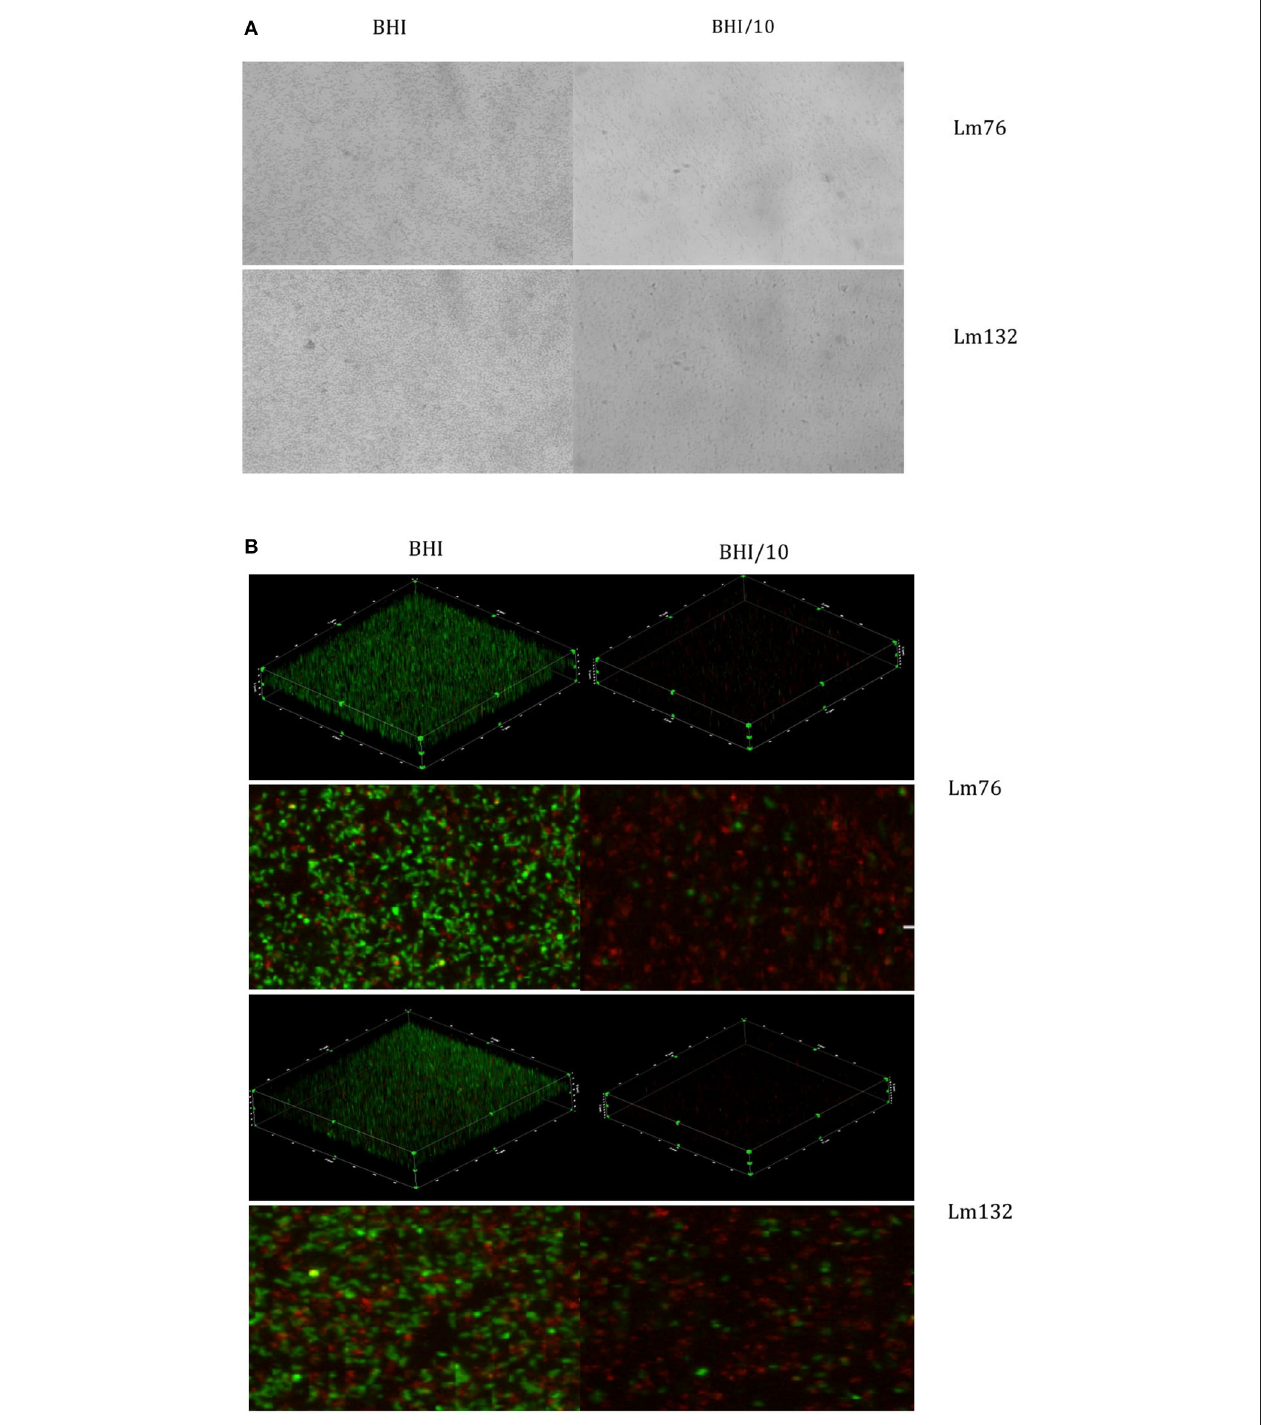
FIGURE 3 | Biofilm visualization of two strains of Listeria monocytogenes : Lm76 and Lm132 after 24 h of incubation at 30 ◦ C static conditions. Biofilm was grown in BHI medium (right images) and BHI/10 (left images); (A) Biofilm stained with Crystal violet 0.1% (B) 3D reconstruction, zoomed images of a view from above of L. monocytogenes biofilm stained with live/dead; Syto9 showing live cells in green and Propidium Iodide showing dead/damaged cells and e-DNA in red.